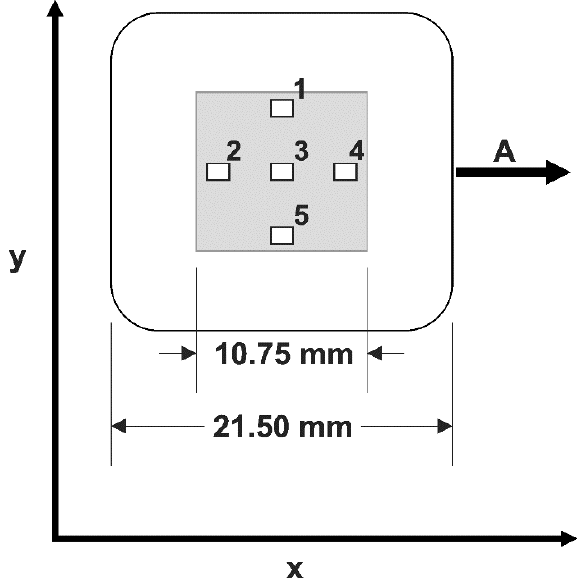
Figure 2. Local strains were determined in five regions (1–5; size 1.40 mm × 1.05 mm) within the inner square of elastic chambers. The chamber was stretched in x direction (A). Sketch to scale. Results of calibration are presented in Table 1.